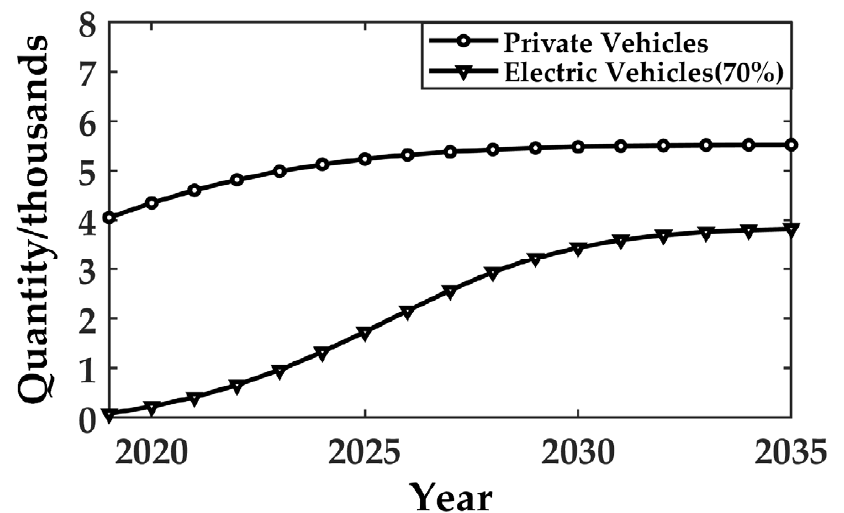
( b ) Weekends Figure 7. Typical daily load power in residential areas. Table 3. Priority of EV access nodes in each power distribution area. Power Distribution Area Level 1 Level 2 Level 3 Level 4 Level 5 Level 6 Level 7 Level 8 Level 9 Level 10 Level 11 Area I - - - - - - 5.4. Simulation Results Fitting the private vehicles growth rate data in Table 2, the fitting result can be ex- pressed as 2 ( ) ( ) e t b c f t a − − = (12) where a , b , and c are the fitting curve parameters for a = 0.4652, b = 2003, and c = 12.51, respectively.